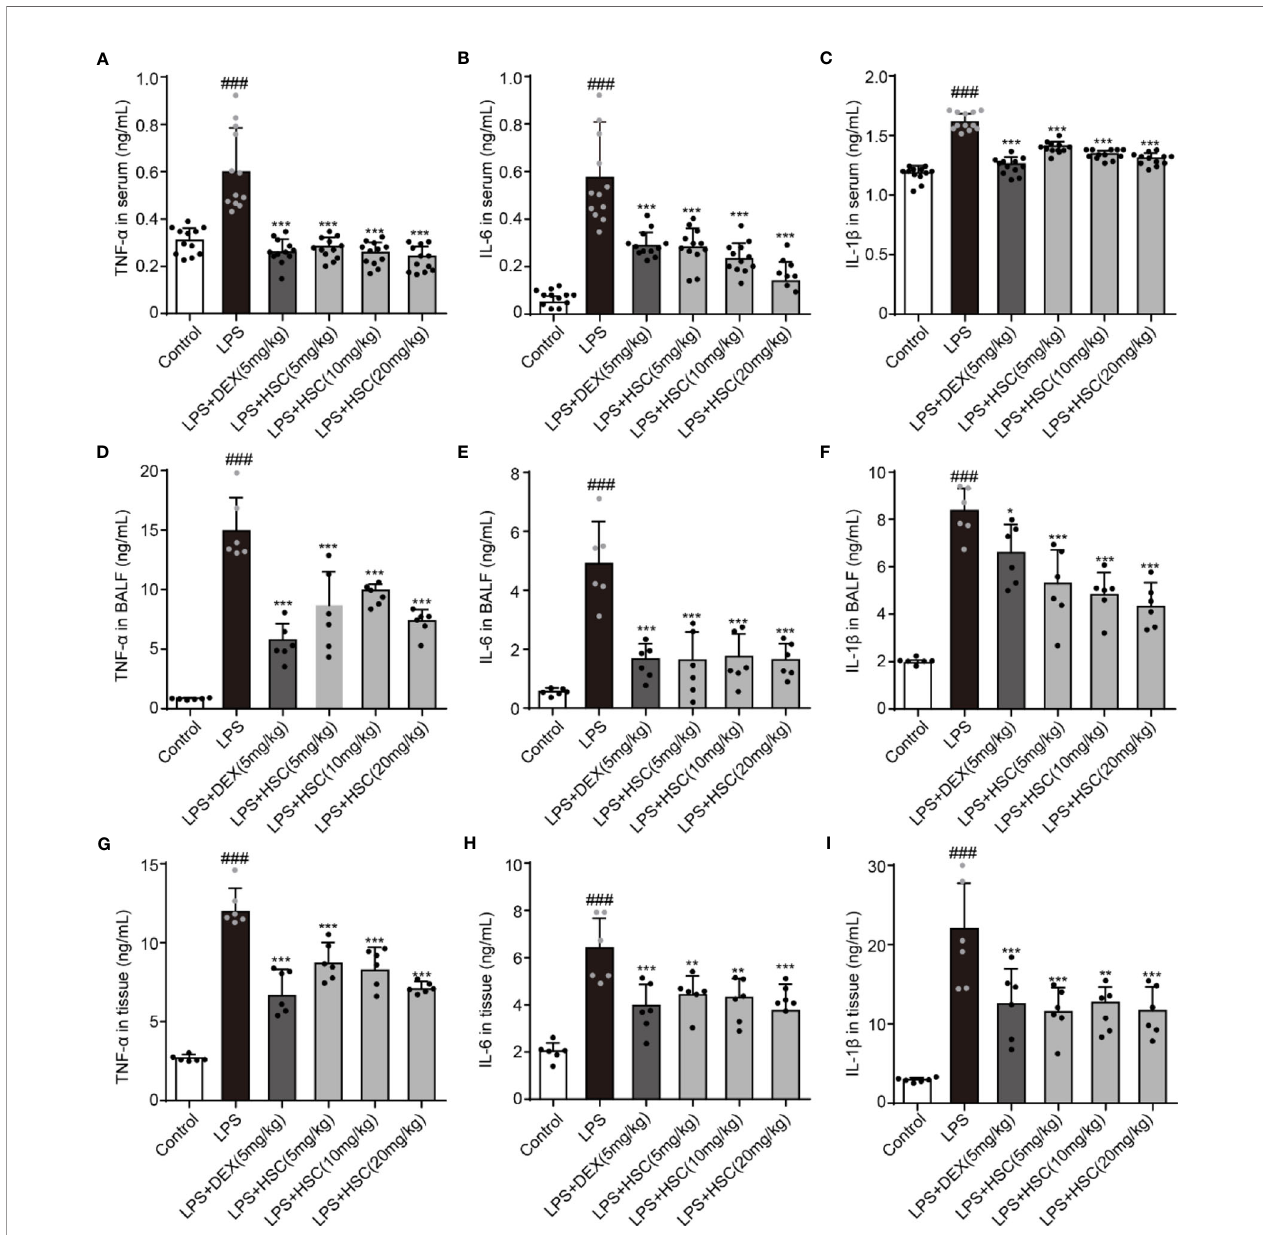
FIGURE 9 | HSC regulates the in fl ammatory process of ALI. The mice were treated with LPS (4mg/kg, i.t.). After LPS injection, mice were treated with HSC at 0 and 12 h, and the corresponding indexes were measured 24 h later. (A – C) The serum of mice was collected to determine the in fl ammatory cytokines TNF- a , IL-1 b and IL-6 were detected by ELISA (n=12); (D – F) The BALF of mice were collected to determine the in fl ammatory cytokines TNF- a , IL-1 b , and IL-6 were detected by ELISA (n=6); (G – I) The lung tissue of mice were collected to determine the in fl ammatory cytokines TNF- a , IL-1 b and IL-6 were detected by ELISA (n=6). ### P < 0.001 compared to control alone group; * P < 0.05, ** P < 0.01, and *** P < 0.001 versus the LPS